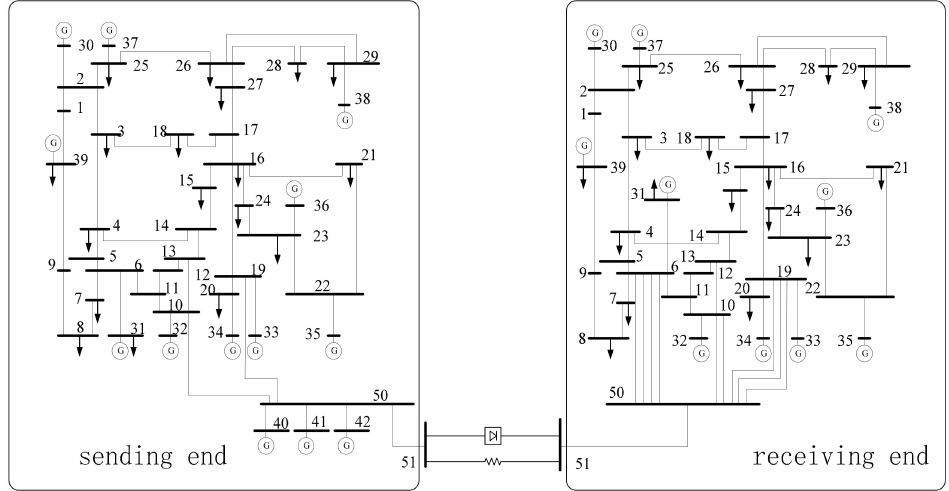
Figure 3. The topological structure of the two-area IEEE-39 AC / DC parallel interconnected power